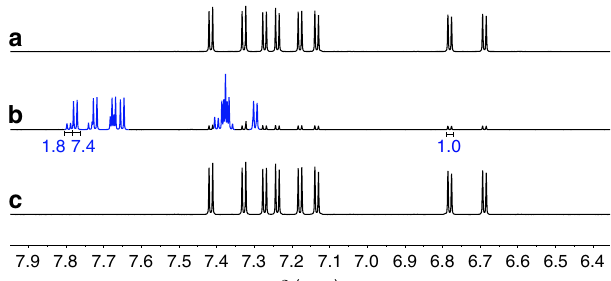
Fig. 4 Photo- and thermal-isomerization monitored by NMR. 1 H NMR spectra of 3b a in the pristine state, b in the photostationary state ([ 4b + 4c ]/[ 3b ] = 90/10 from the integrations of the peaks at 7.77 − 7.80 ppm and 6.78 − 6.79 ppm) and c in the recovered state after being heated at 40 °C for 8 h in CD 2 Cl 2 (4.6 mM).